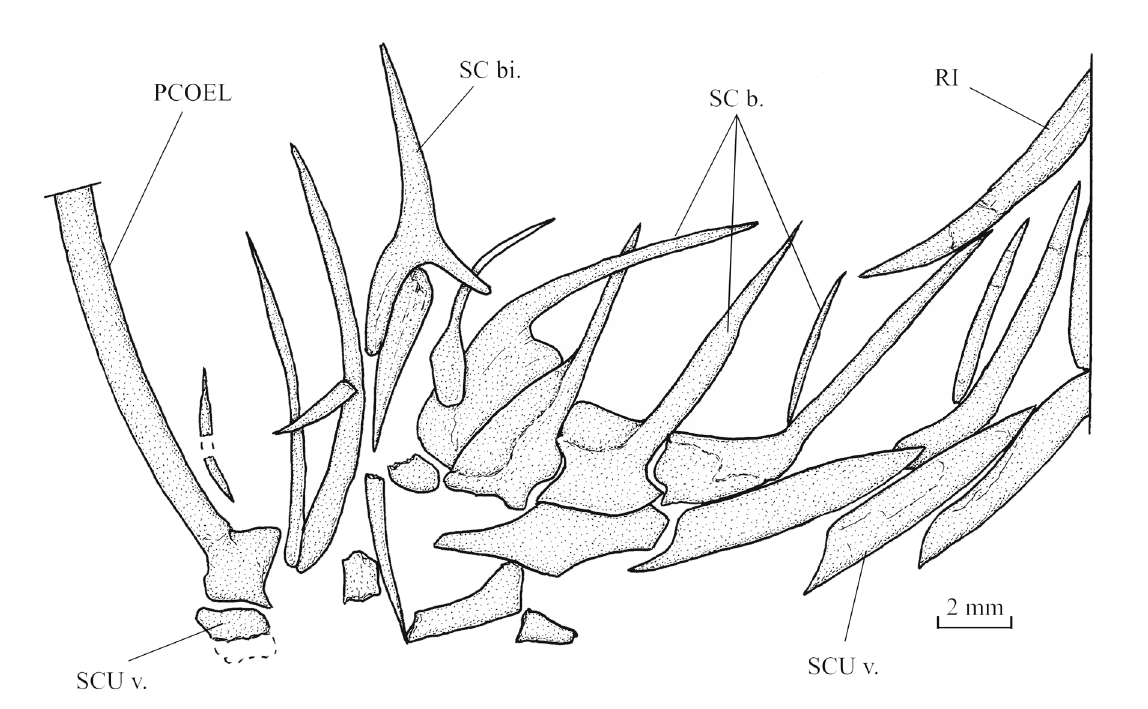
Fig. 23. Pseudopycnodus nardoensis (Taverne, 1997), cloacal region of specimen CLC